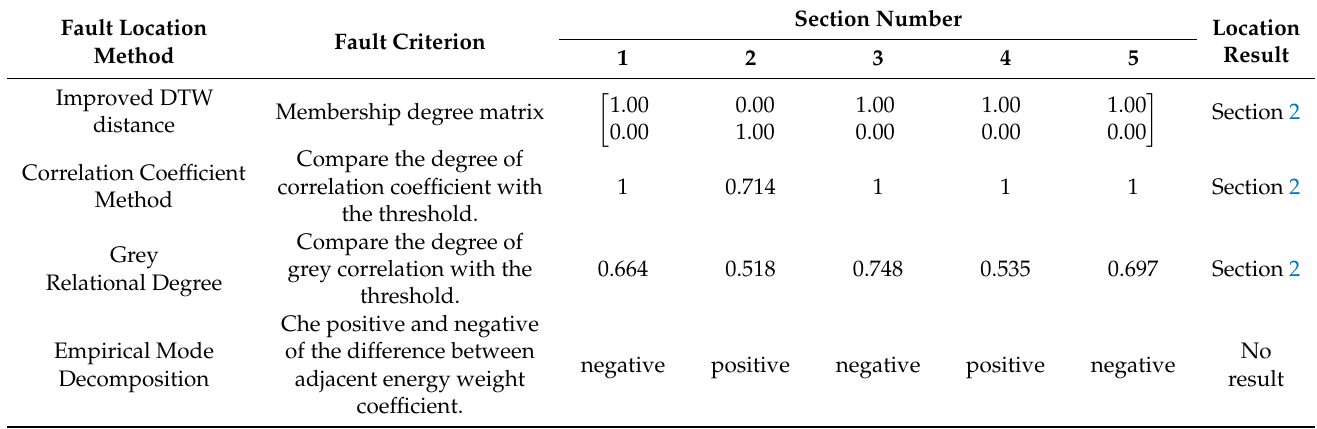
Table 7. Comparison with other positioning